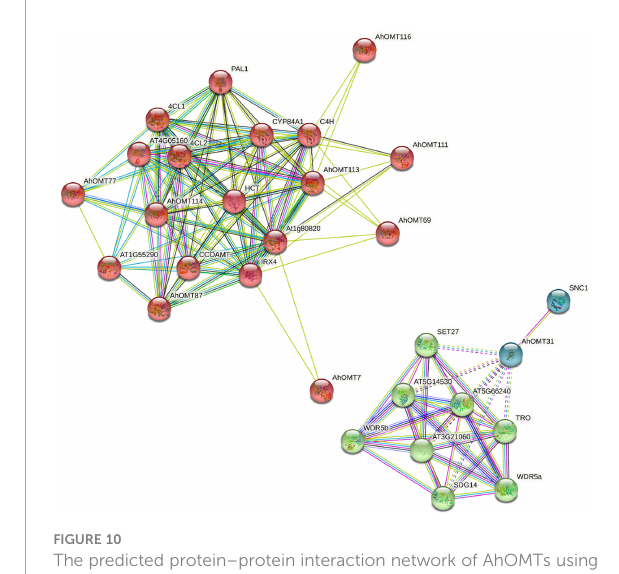
FIGURE 10 The predicted protein – protein interaction network of AhOMTs using STRING database. Putative protein functions of AhOMTs are predicted on well-studied OMT orthologues in Arabidopsis